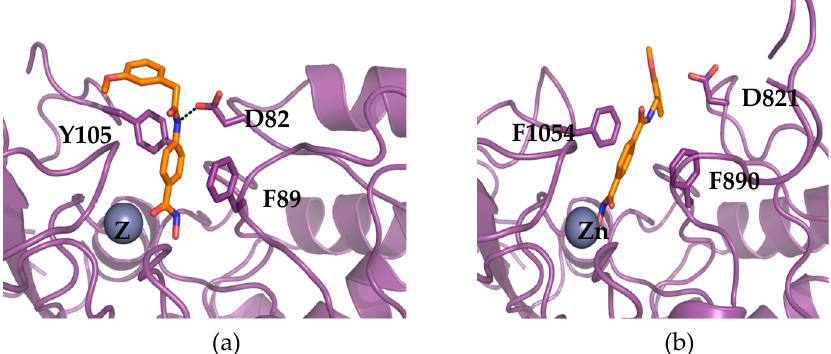
Figure 2. Docking of 363 and D16 in the models of TgHDACs. Model of S8GEI3_TOXGM from T. gondii M49 in complex with ligand 363 ( a ). Model of the same target from T. gondii in complex with ligand D16 ( b ). Both models were produced using the server @TOME-2 and their active site delineated around the co-crystallized ligand of the templates. Ligands were docked in 5–10 distinct models by the software PLANTS using the co-crystallized ligand as a shape restraint. The most representative configurations were selected and correspond to models based on the templates PDB5WGM and PDB5G1A for 363 and D16, respectively. The putative binding site of the zinc atom is indicated by a grey sphere labeled with the symbol Zn. The chelating sidechains are not shown for clarity. On the contrary, the two phenylalanine (F890 and F1054) and the aspartate (D821) residues interacting directly with the benzohydroxamate moieties are shown (in stick). The two ligands are indicated in orange stick and the protein backbone in violet ribbon. The only hydrogen bond shown is with this aspartate (black dashed line) and it is predicted to discriminate between compound 363 and D16. The figure was drawn using pymol (www.pymol.org)